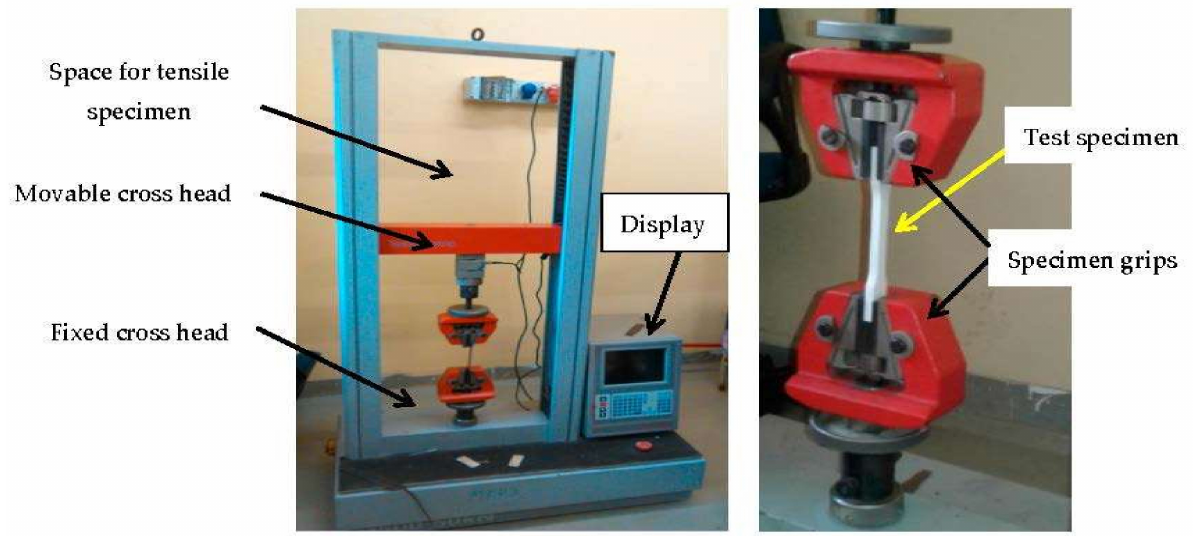
Figure 2. Universal testing machine with testing specimen.